Question: Write a caption explaining this figure to a reader.
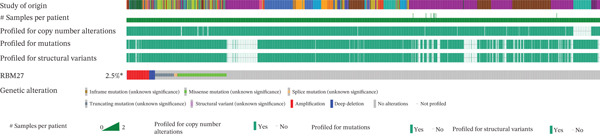
Answer: RBM27 gene mutation frequency, type, and its relationship with expression level. (a) Frequency of RBM27 gene mutations in 10,967 samples. (b) Frequency of RBM27 gene mutations in various cancers. (c) Mutation types and proportions of RBM27. (d–e) Relationship between copy number and mRNA expression of RBM27 and gene mutations.